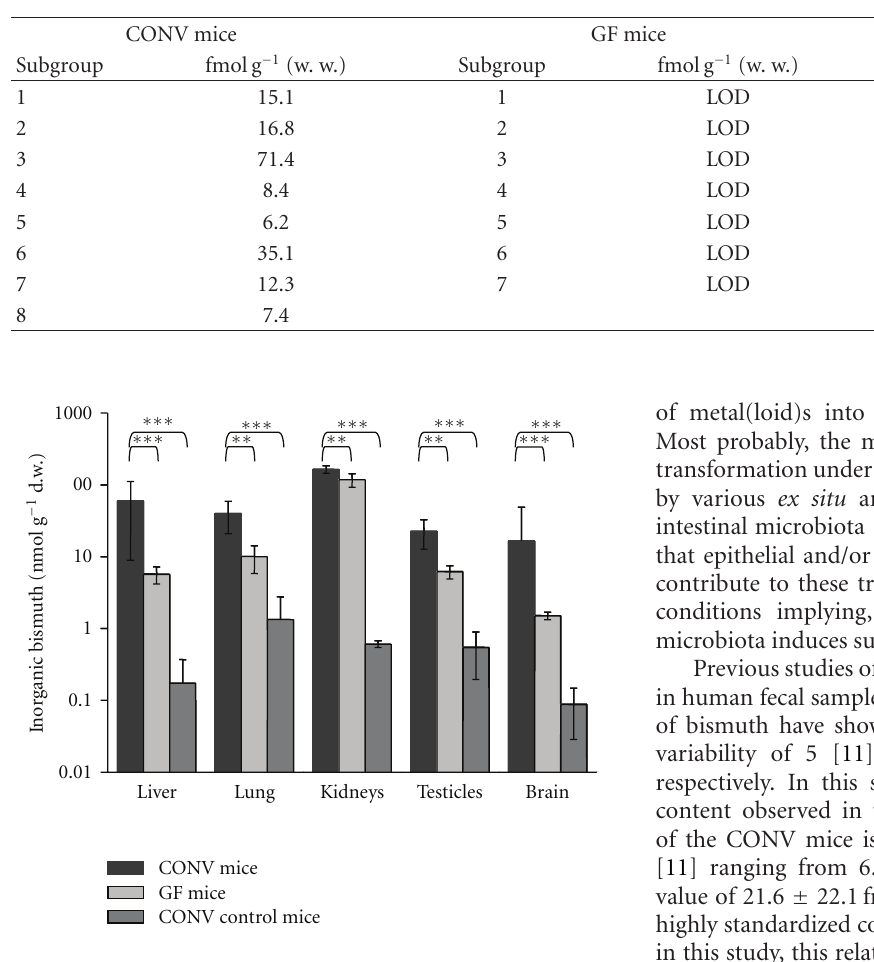
Table 1: (CH 3 ) 3 Bi content in blood samples of CONV and GF mice fed with CBS containing chow and CONV control mice on standard diet. The absolute limit of detection (LOD) for (CH 3 ) 3 Bi based on the 3 σ criterion was 1.5fmol, whereas the relative LOD was between 4.5 and 6fmolg − 1 .